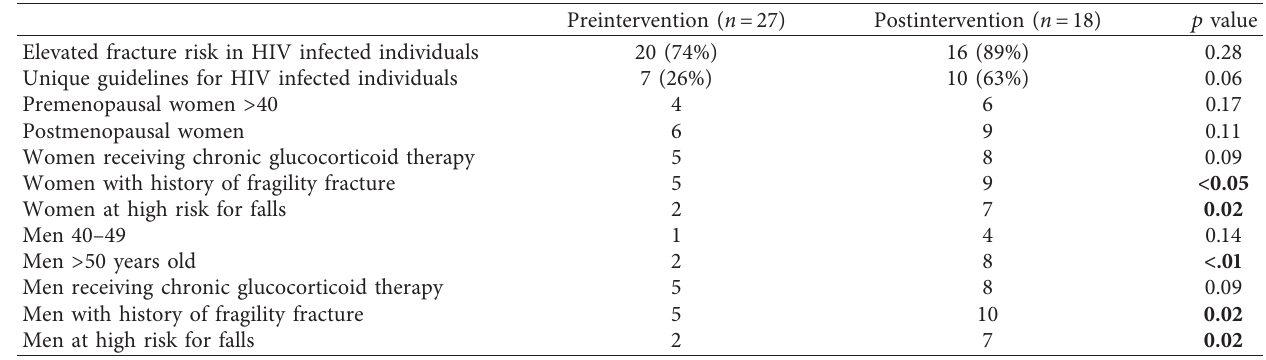
Table 1: Pre- and postintervention results of faculty survey.